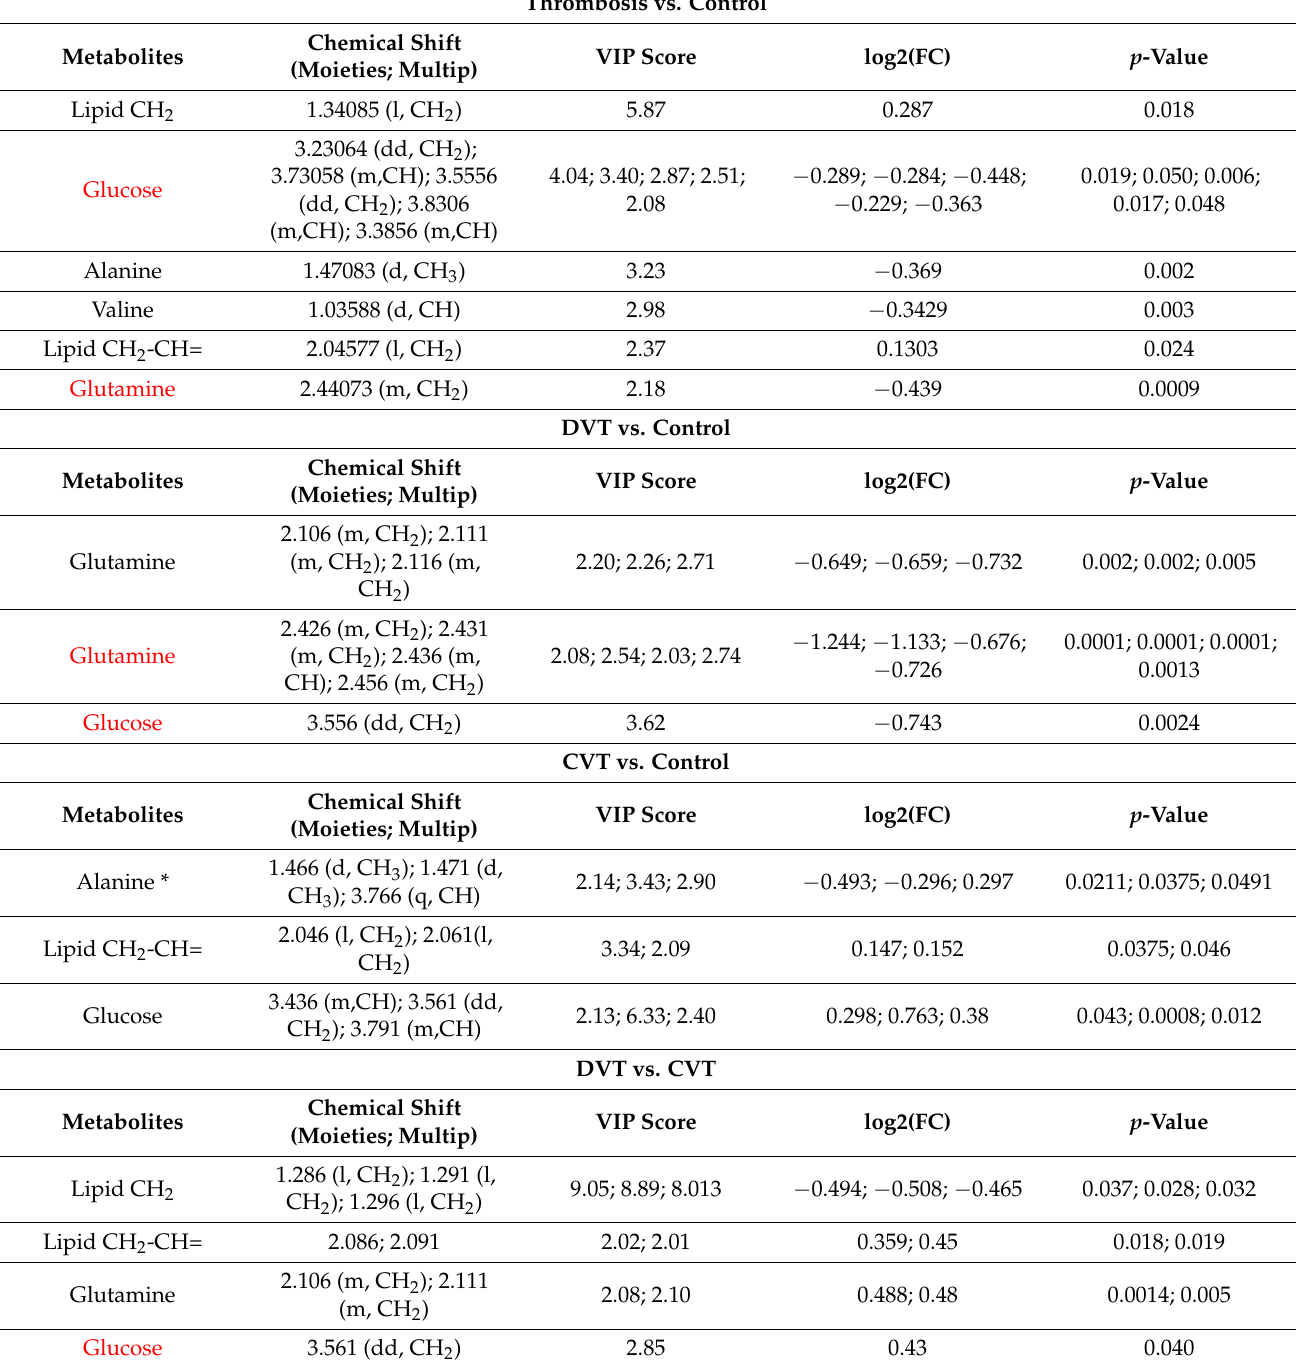
Table A4. Table showing the identified metabolites and their chemical shift properties elucidated by Table 2. 0; multip = multiplicity, where s (singlet), d (doublet), t (triplet), dd (doublet of doublet), l (broad). In red are VIPs with p < 0.05, according to the linear regression model. * Overlapping